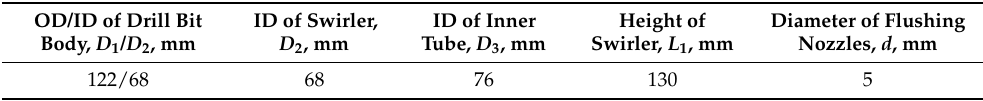
Table 1. Structural parameters of the swirling drill